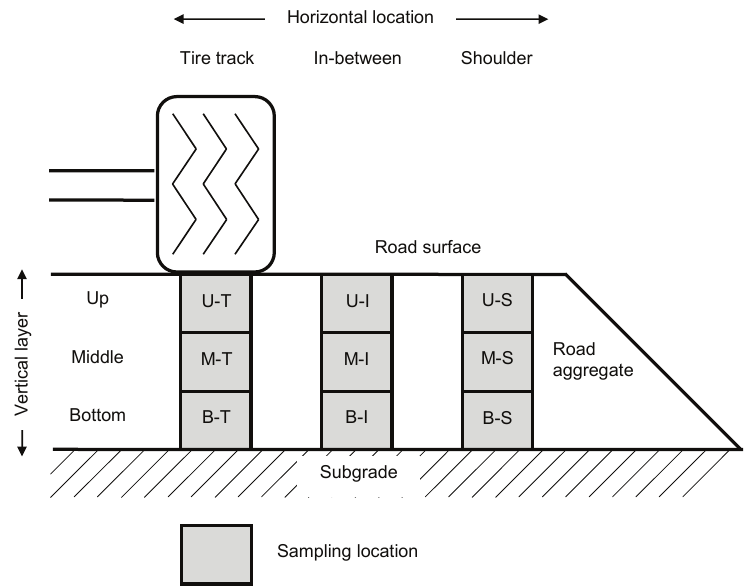
Figure 2. Forest road cross-sectional locations of observed particle size distributions (PSDs). The abbreviations indicate vertical and horizontal locations of observed PSDs. U: Upper; M: Middle; B: Bottom; T: Tire track; S: Shoulder; I: In-between